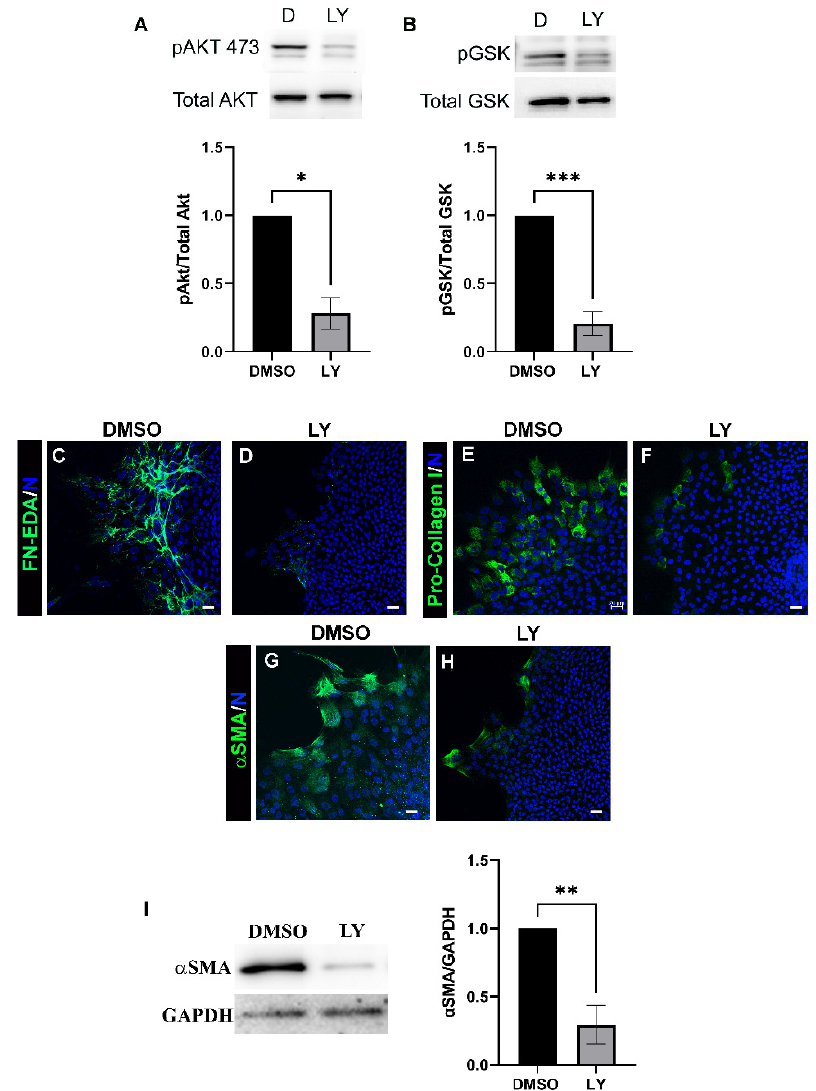
Figure 1. PI3K signals production of FN-EDA, pro-collagen I and differentiation into α SMA+ myofibroblasts post-wounding. Ex vivo post-cataract surgery explants were treated with vehicle (DMSO) or pan-PI3K inhibitor LY294002 (LY) on day 1 through day 3 and subjected to immunoblot analysis ( A , B ) to determine the activation state of the PI3K effector Akt and phosphorylation of GSK by immunoblotting ( A ) phosphoSer473-Akt (pAkt) and total Akt and for ( B ) phospho-GSK (Ser9) and total GSK. Results show that LY294402 treatment effectively suppressed Akt and GSK phosphorylation. Quantification of the relative intensity of pAkt/total Akt, pGSK/total GSK normalized to DMSO is displayed in bar graphs. ( C – H ) D3 LY294002 and vehicle treated ex vivo post-cataract surgery explant cultures were immunolabeled for ( C , D ) FN-EDA, ( E , F ) pro-Col I, ( G , H ) α SMA, co-labeled for DAPI and imaged by confocal microscopy. LY294002 treatment effective suppressed FN-EDA, pro-Col I and α SMA. All images are presented as projections from collected confocal z-stacks. Magnification bars = 20 µm. ( I ) Immunoblots of Day 3 LY294002 and vehicle treated ex vivo post-cataract surgery explants shown for α SMA and loading control GAPDH. Quantification of the relative intensity of α SMA and GAPDH normalized to DMSO is displayed in bar graphs ( n = 3). Error bars represent S.E.M., * p ≤ 0.05, ** p ≤ 0.01, and *** p ≤ 0.001.